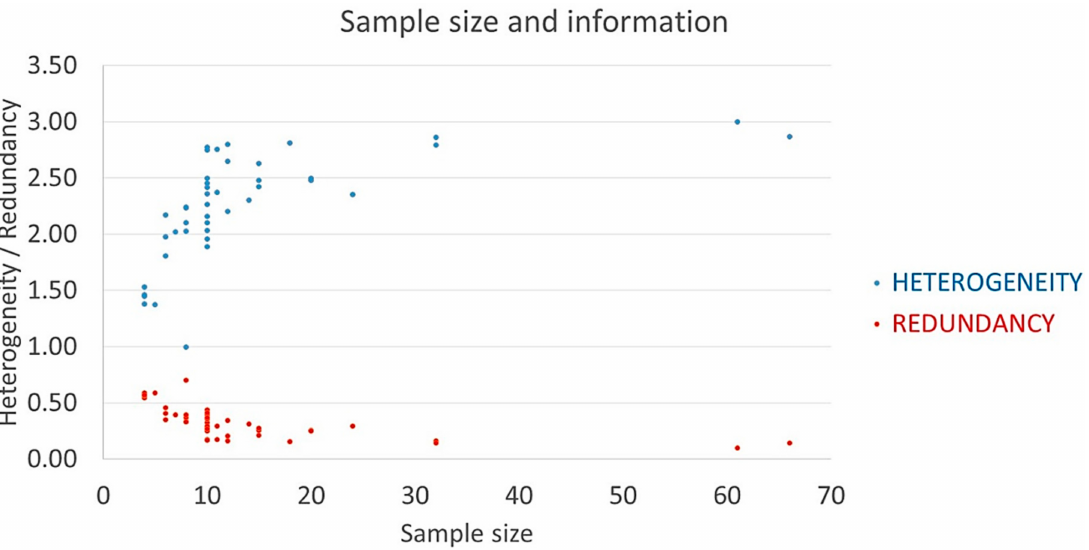
Figure 7. Sample size and information